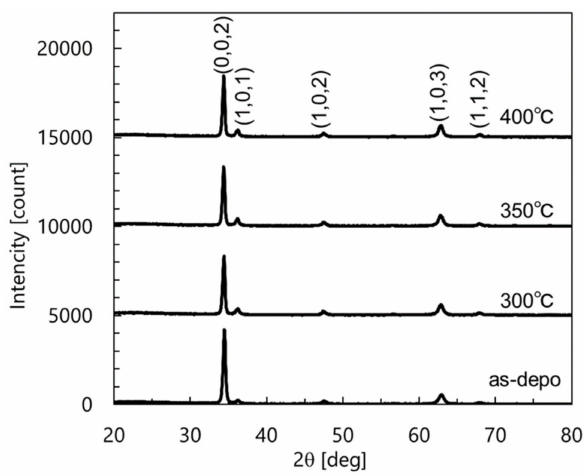
Figure 3. X-ray diffraction (XRD) spectra of ZnO films at various annealing temperatures.